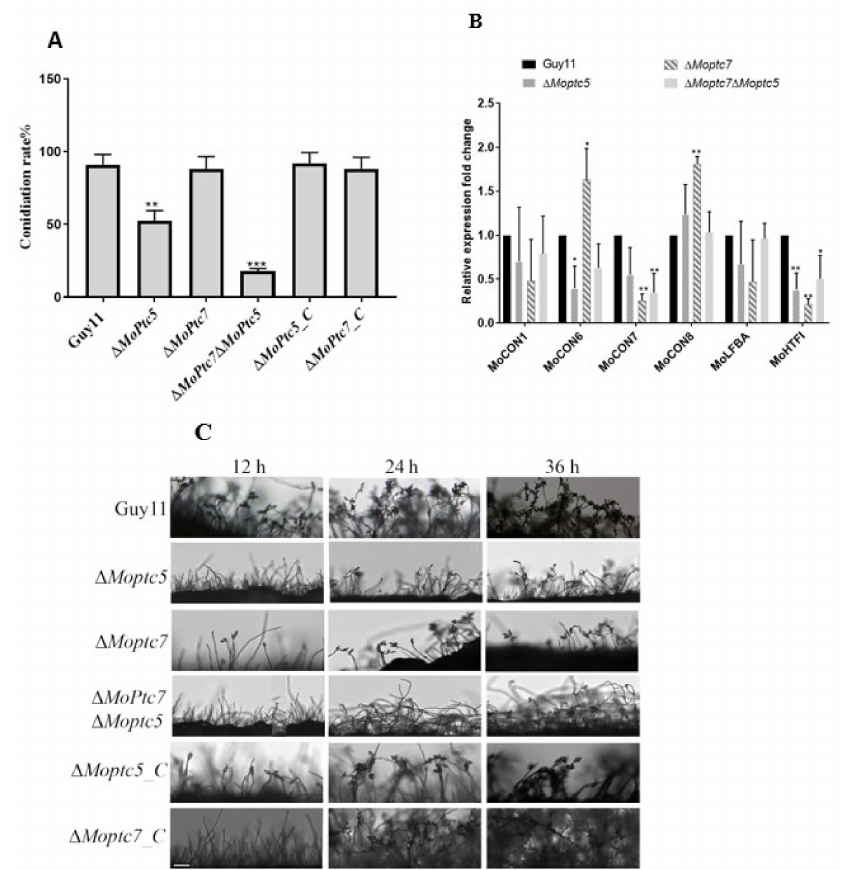
Figure 4. MoPTC5 deletion causes reduction in conidiation and conidiophores formation of M. oryzae . ( A ) Conidia production of the strains grown on RBM for 10 days period. ( B ) Conidiophores formation from Guy11, ∆ Moptc5, and ∆ Moptc7 ∆ Moptc5 strains on RBM. ∆ Moptc7 ∆ Moptc5 double mutant shows highly reduced conidiophores formation. ( C ) Relative expressions of genes involved in M. oryzae conidiation. The various strains were inoculated in liquid CM and incubated at 28 ◦ C under constant shaking at 110 rpm for 3 days, after which total RNAs were extracted for qPCR analysis. Tubulin gene was used as a control. Results are means obtained from three independent replicates. Error bars represent standard deviations while asterisks show significant differences at different p -values (*, p < 0.1; **, p < 0.01; ***, p < 0.001)). The data were analyzed by one-way ANOVA using Tukey’s multiple-comparison